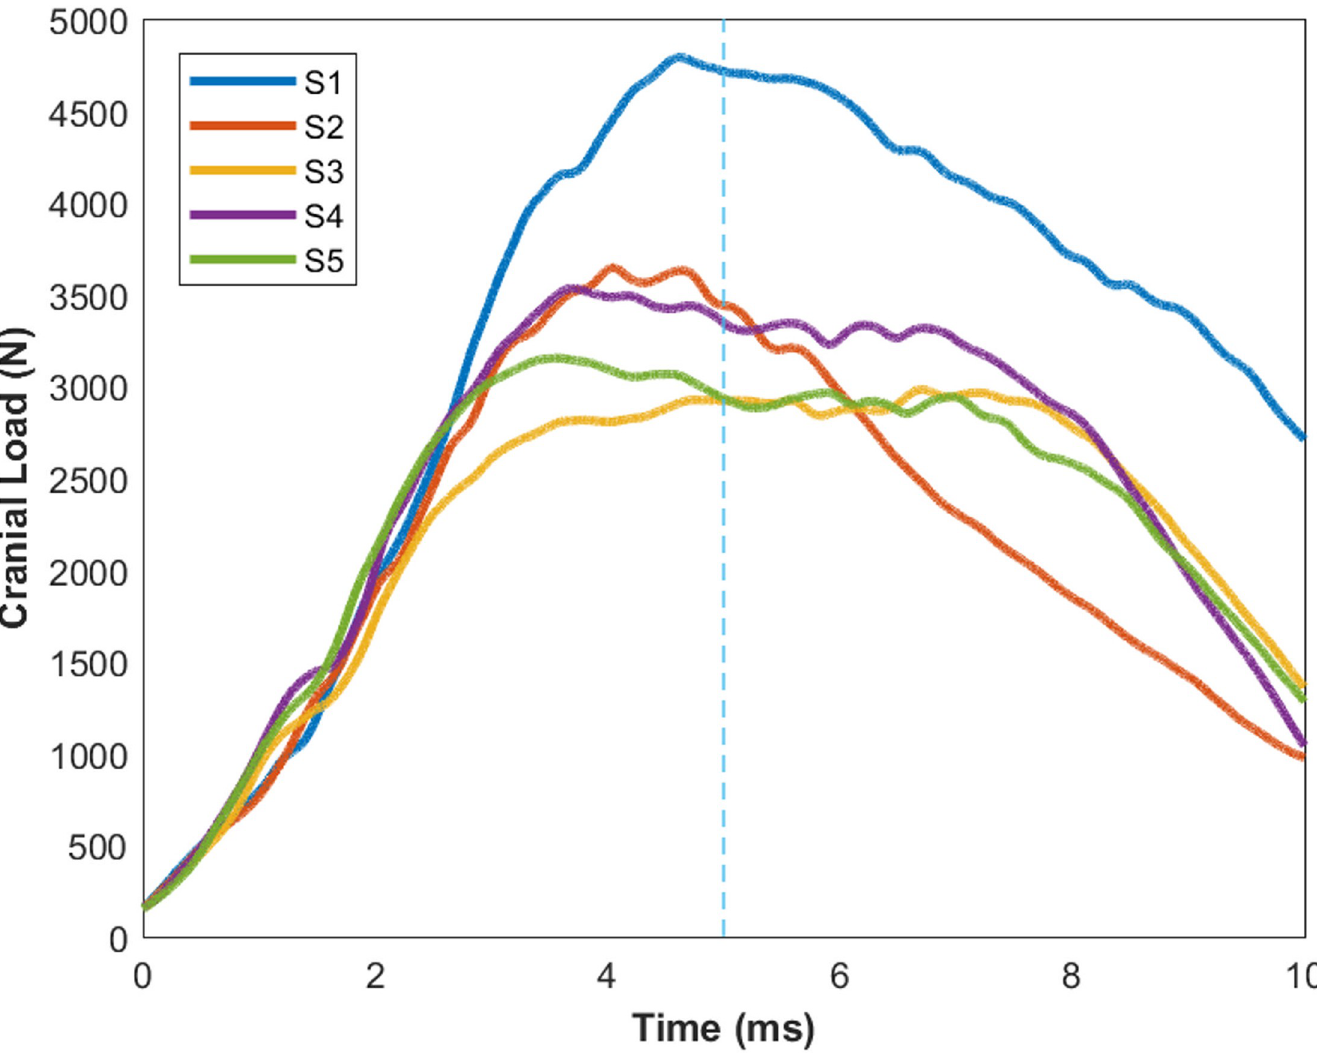
Fig 4. Axial loads measured at the cranial load cell during the experiments. The initial 5 ms (segmented vertical line) of the load traces were used to drive the forward dynamics simulations by applying them to the centre of mass of the C2 segments of the models. parameter values. The genetic algorithm evaluated 100 sample populations over 15 generations